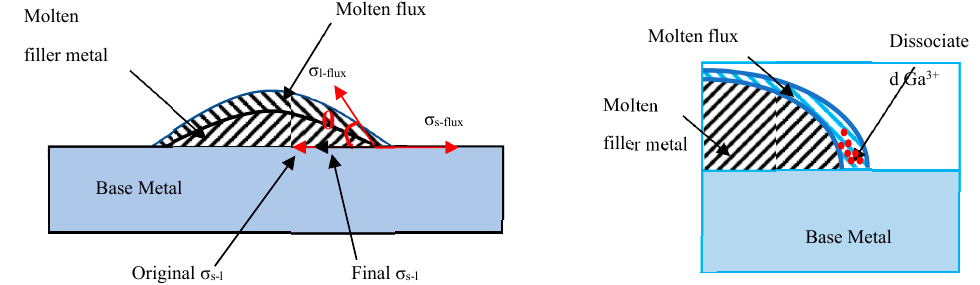
Figure 7. Diagrammatic sketch of Zn-Al spreading on base metal.